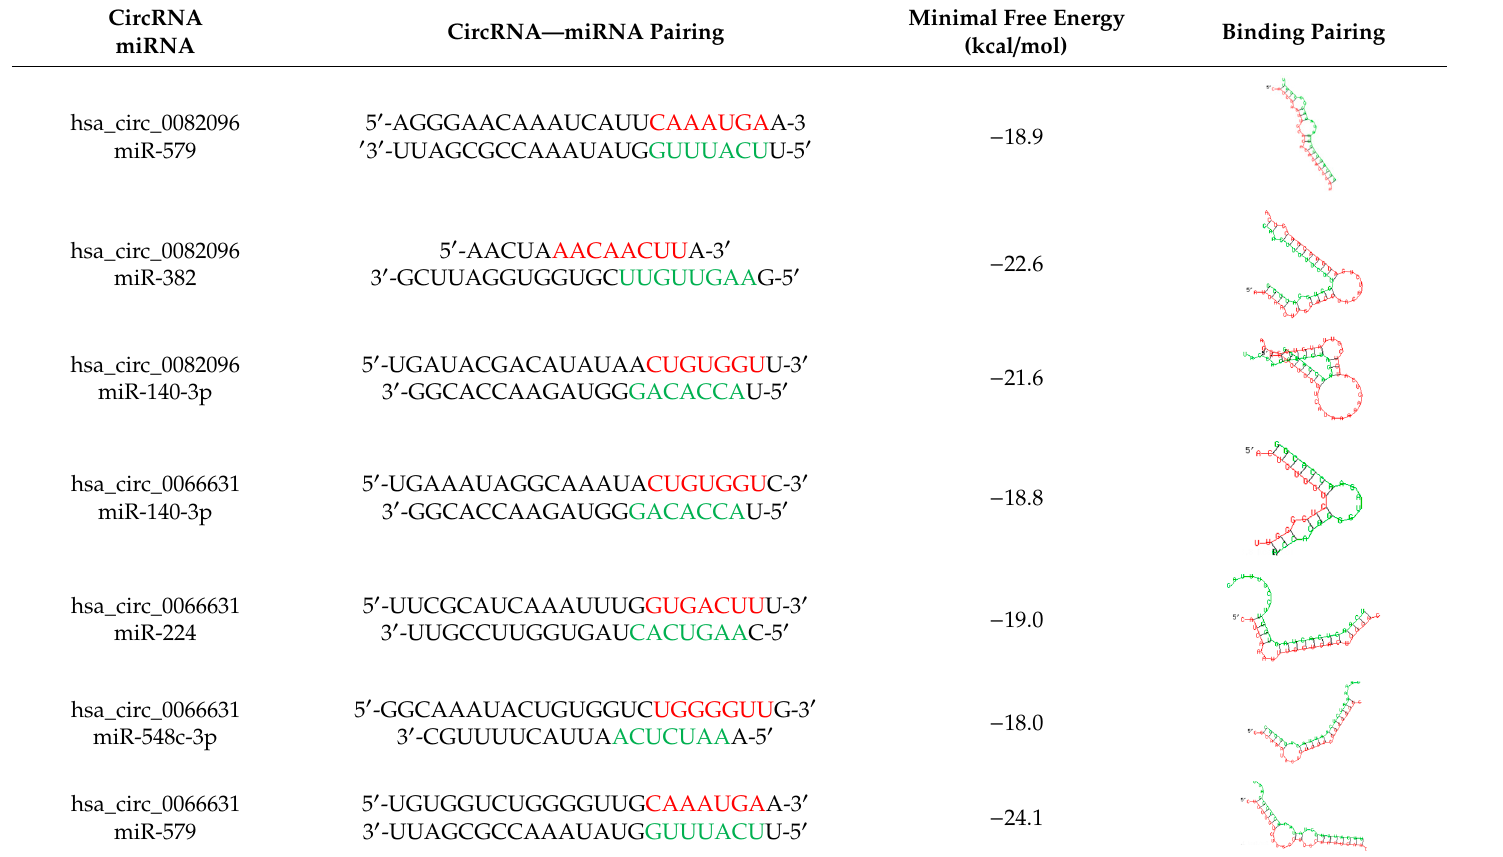
Table 3. Predicted circRNA–miRNA binding activity.